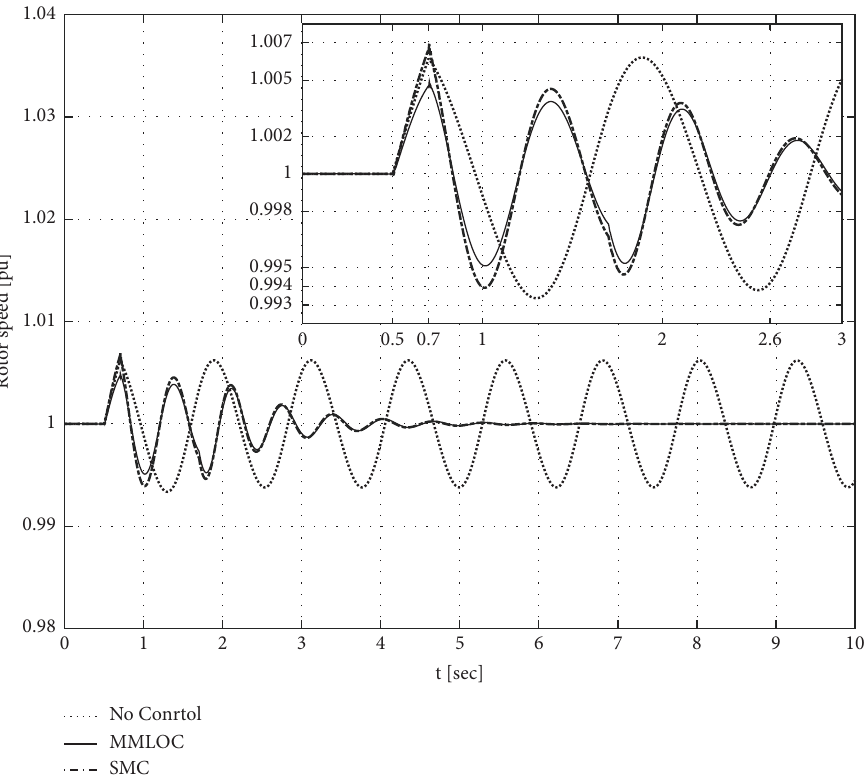
Figure 5: Rotor speed of the generator with MMLOC and SMC and without control.